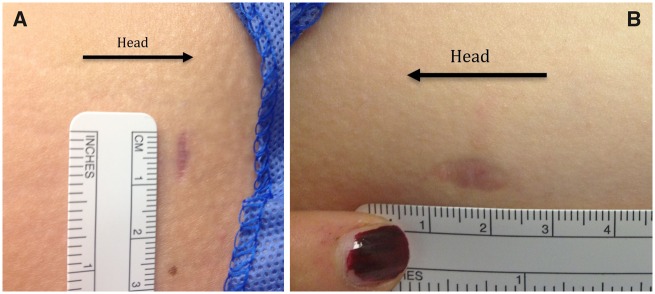
Clinical photographs of incision-site healing at 3 months postoperatively. (A) Transverse portal on the left thigh noted to heal with thinner scar compared to longitudinal portal on the right thigh (B).